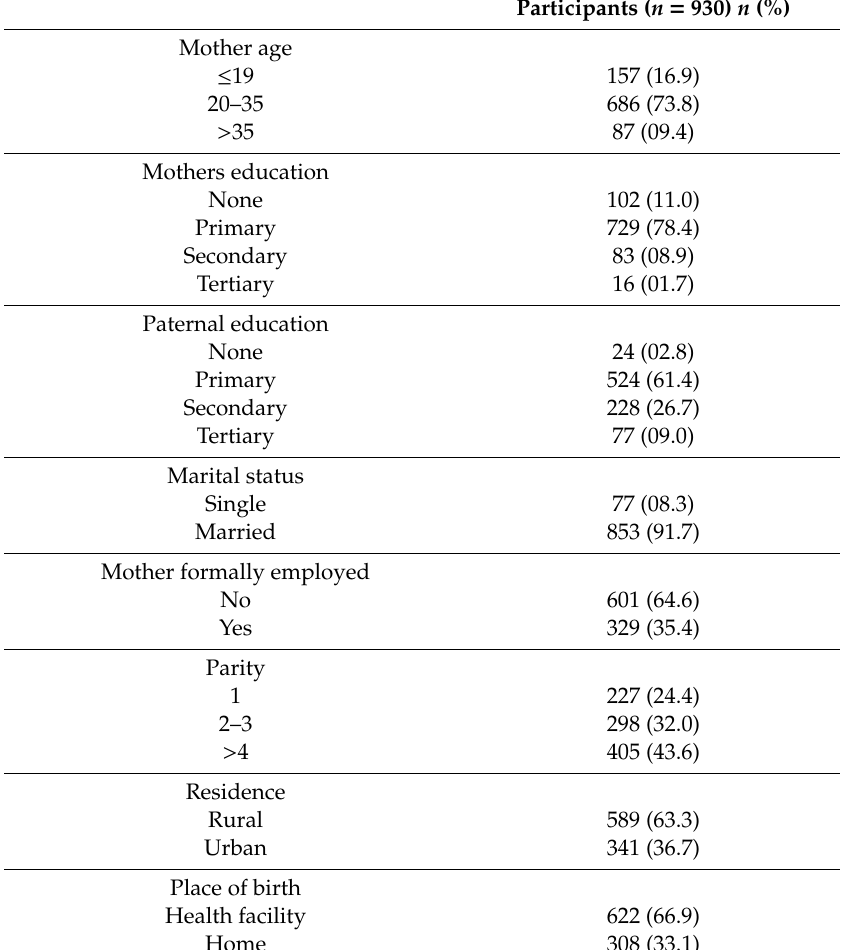
Table 1. Baseline characteristics of mothers surveyed in the Lira district, Northern